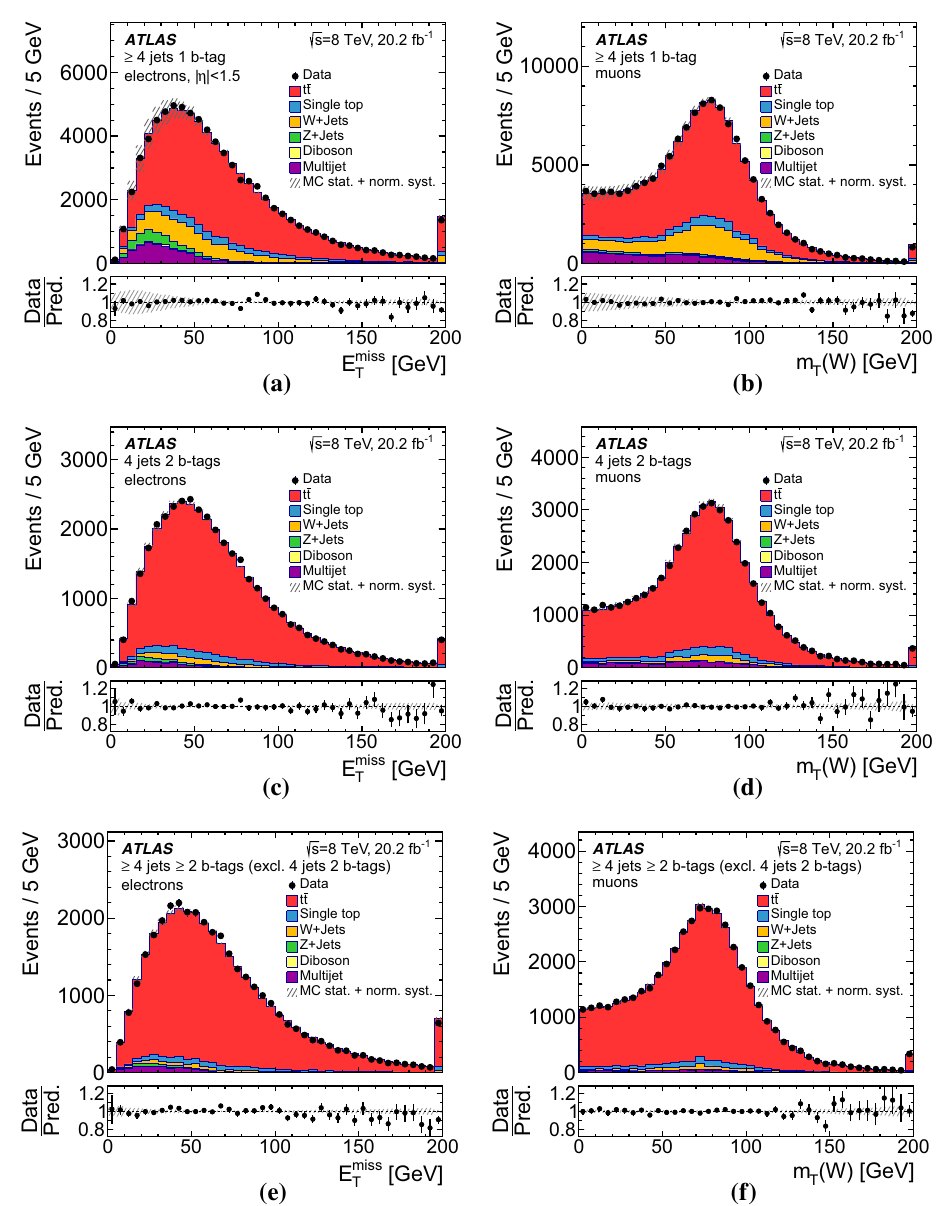
Fig. 2 Observed and simulated (left) E miss distributions in the elec- error bands represent the uncertainty due to the sample size and the nor- T tron channel and (right) m T ( W ) distributions in the muon channel, nor- malisationofthebackgrounds.Theratioofobservedtopredicted(Pred.) malised to the result of the binned maximum-likelihood fit, a for the number of events in each bin is shown in the lower histogram. Events barrel region in SR1, b in SR1, c , d in SR2, and e , f in SR3. The hatched beyond the x -axis range are included in the last